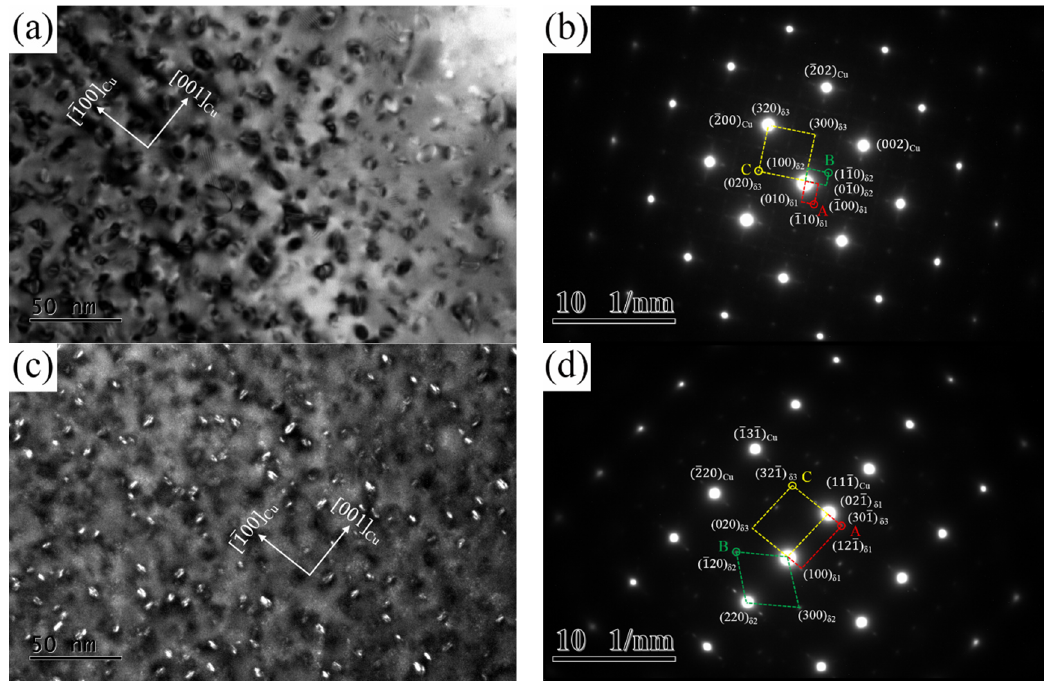
Figure 8. TEM images of the NS-4 alloy aged at 500 ◦ C for 2 h. ( a ) Bright-field TEM image along [001] Cu , ( b ) SAED corresponding of ( a ), ( c ) dark-field TEM image of A, and ( d ) SAED corresponding along [112] Cu .